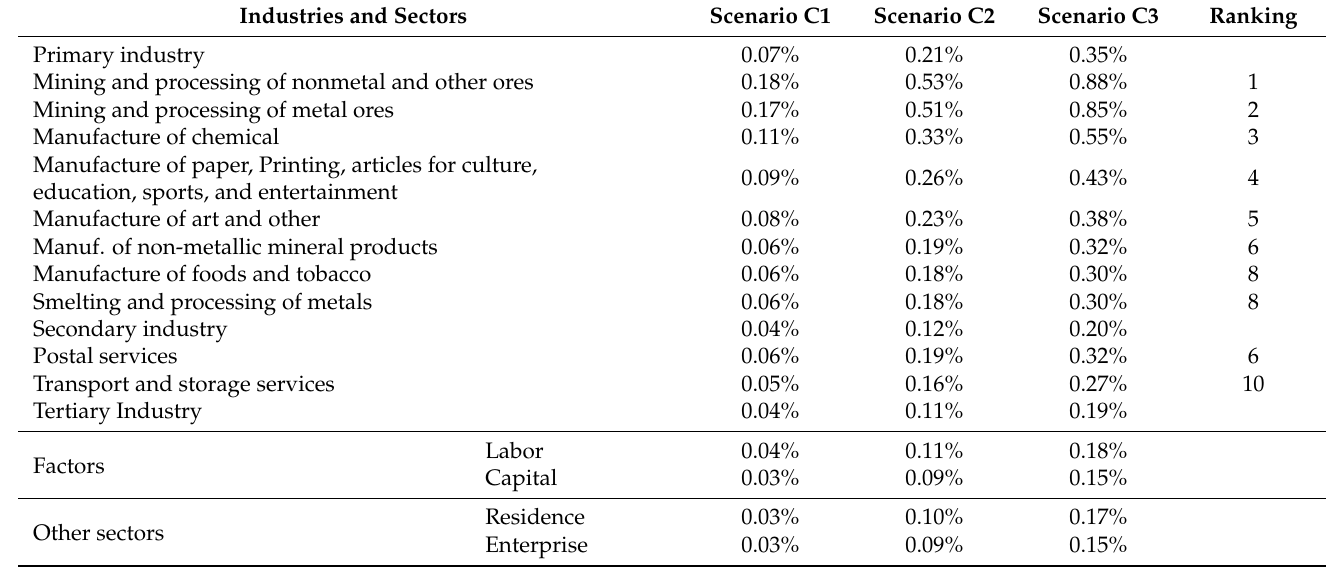
Table 7. Output and income changes of various industries and sectors based on the improvement in energy